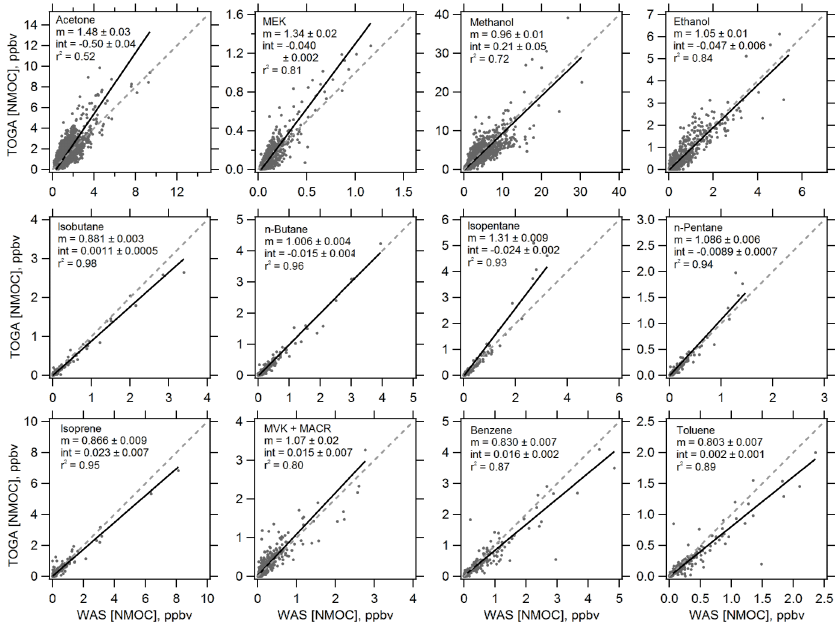
Fig. 2. Comparisons between ARCTAS TOGA and WAS observations for selected co-measured NMOCs, similar to Fig. 1.